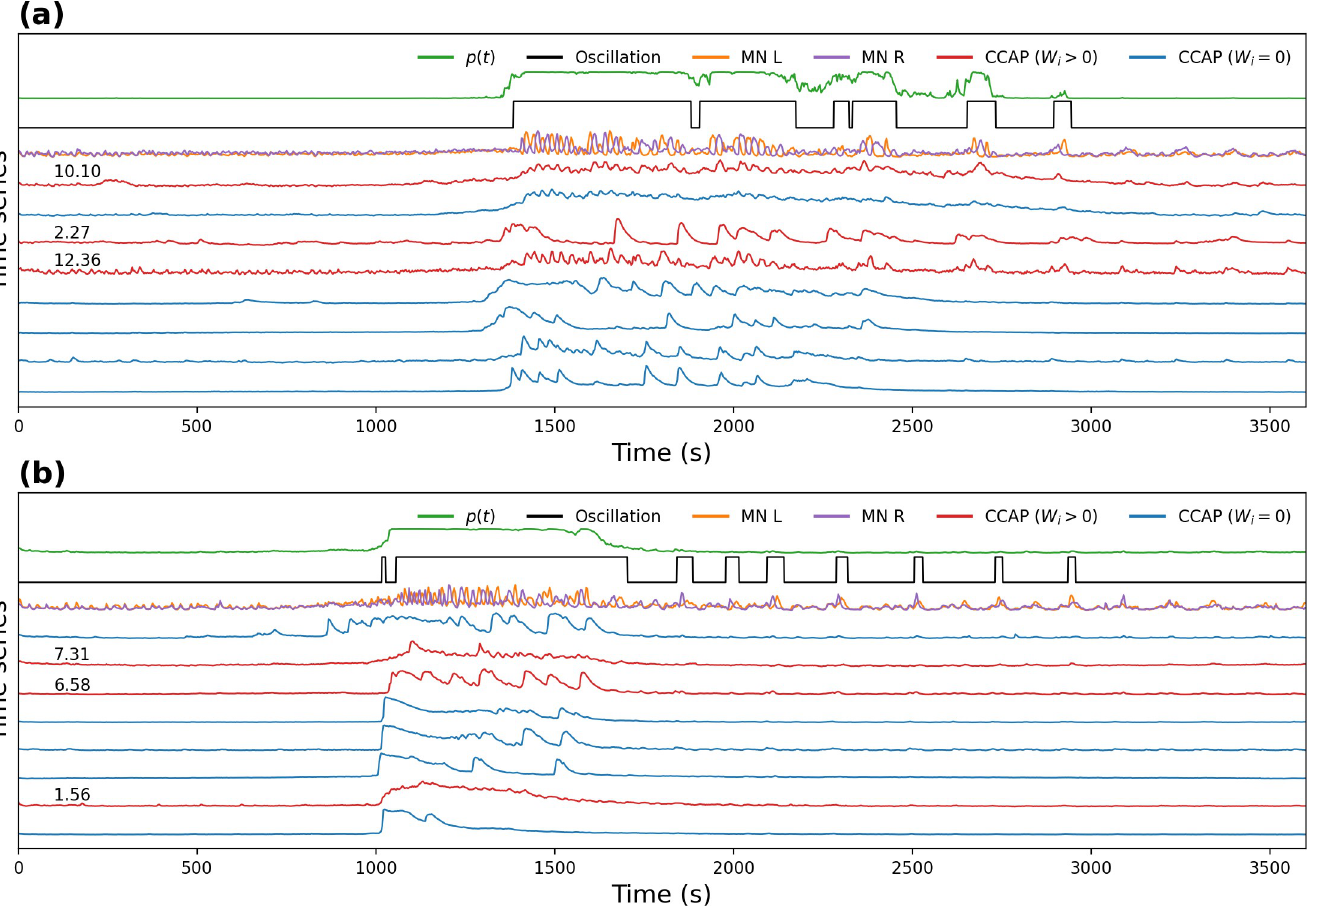
Fig 6. Fit of the logistic model to the experimental data. . (a, b) Time series of α CCAP neurons (red, blue), motoneurons (orange, purple), binarized oscillatory activity of motoneurons (black), and probability of oscillation predicted by the model (green). CCAP activity traces are shown in red with their corresponding weight value if it is positive (“CCAP ( W i > 0)”), or in blue with no value if it is zero (“CCAP ( W i = 0)”). All weight values were computed through multi-weight model fitting. (a) Example of a good match between the model p ( t ) and the oscillatory state of the motoneurons. (b) Example of a poor match during the post-ecdysis phase, as a result of the lack of α CCAP activity.